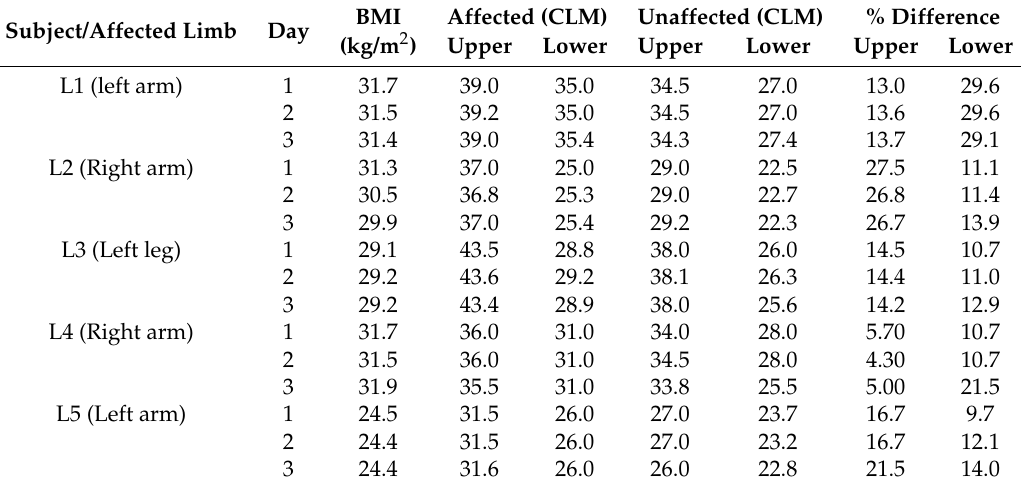
Table 1. Circumferential limb measurements (CLM) measured in centimetres on lymphoedema (L) affected participants.